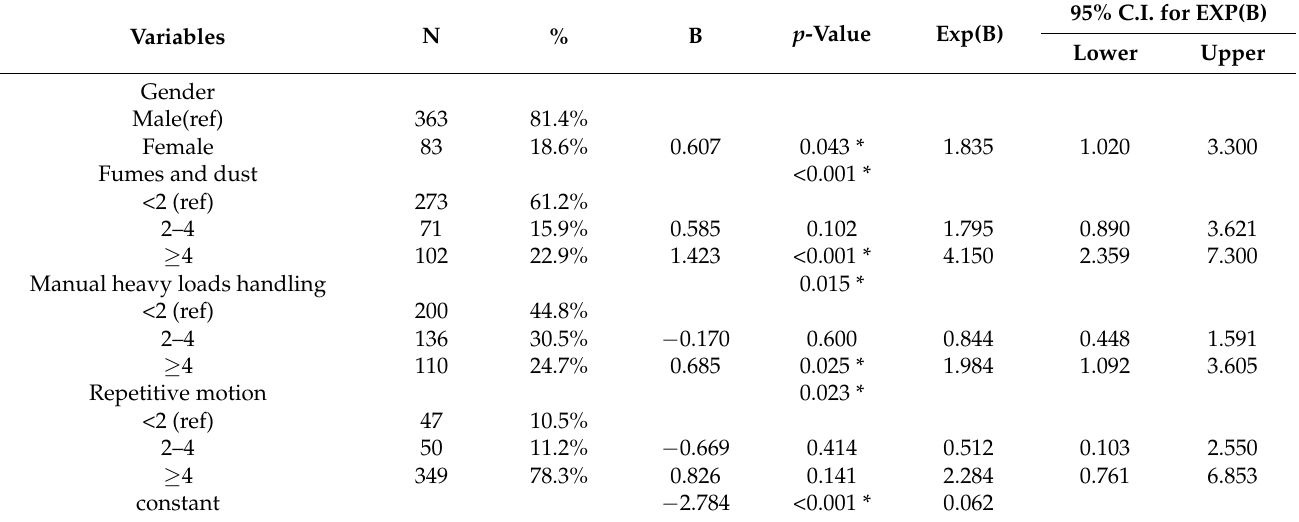
Table 11. Results of logistic regression on overall